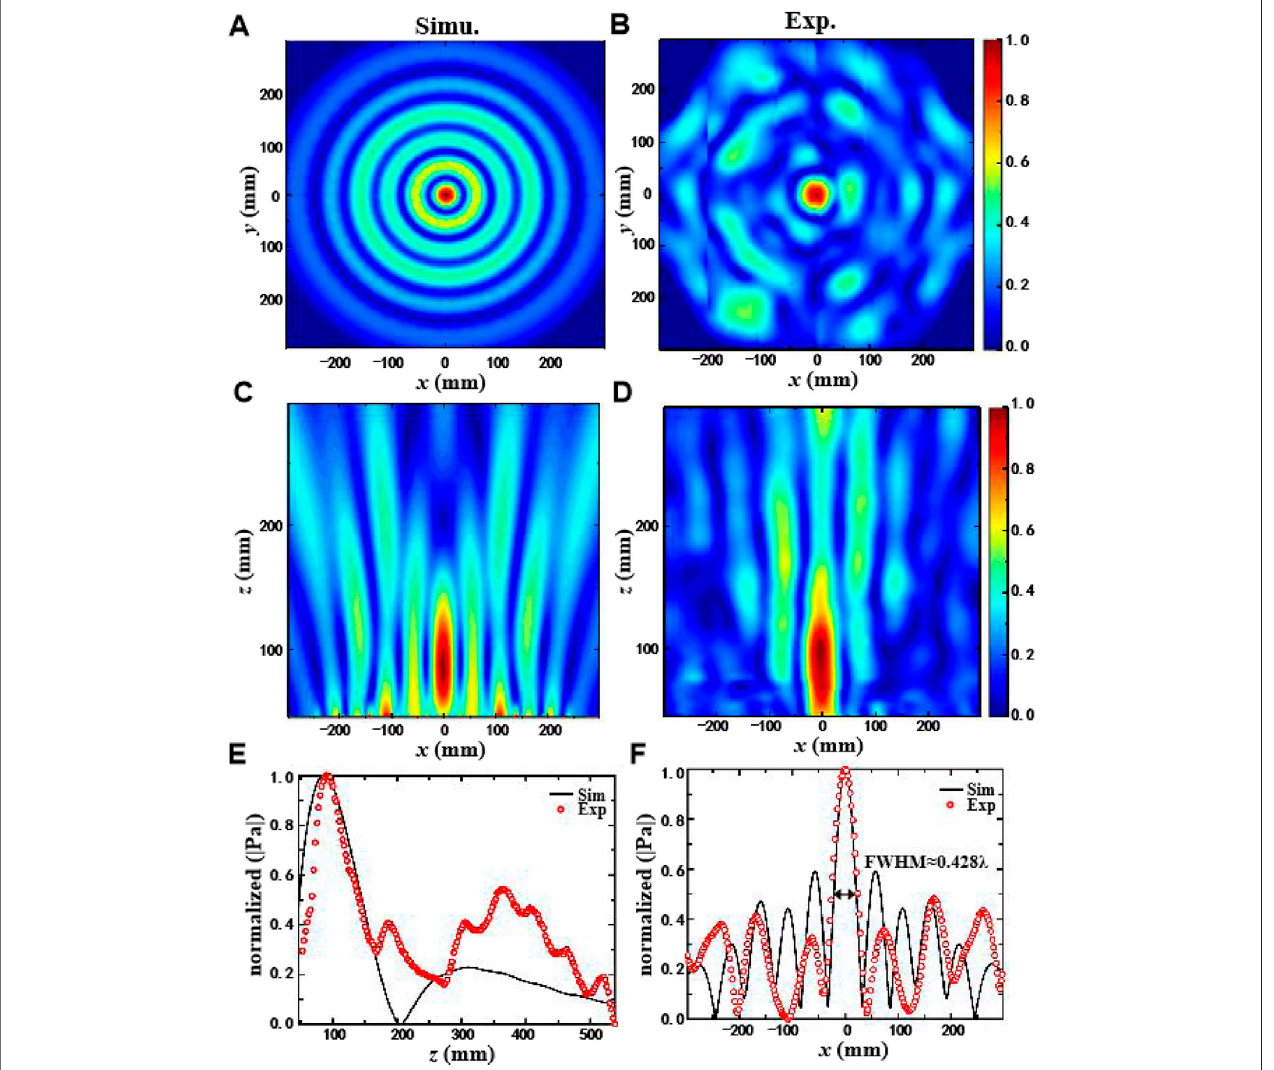
FIGURE 5 | Simulation and experimental measurement diagrams of acoustic meta-lens focusing in the air. (A,B) Numerical simulation results and experimental measurement results of the normalized two-dimensional pro fi le of the acoustic meta-lens sound pressure along the z direction. (C,D) Numerical simulation results and the experimental measurement results of the normalized two-dimensional pro fi le of the acoustic meta-lens sound pressure along the x-y plane. (E) Normalized distribution of the simulated sound intensity (black line) and measured sound intensity (red circle) along the z -axis tangent plane with x = 0. (F) Normalized distribution of the simulated sound intensity (black line) and measured sound intensity (red circle) in the focal plane.